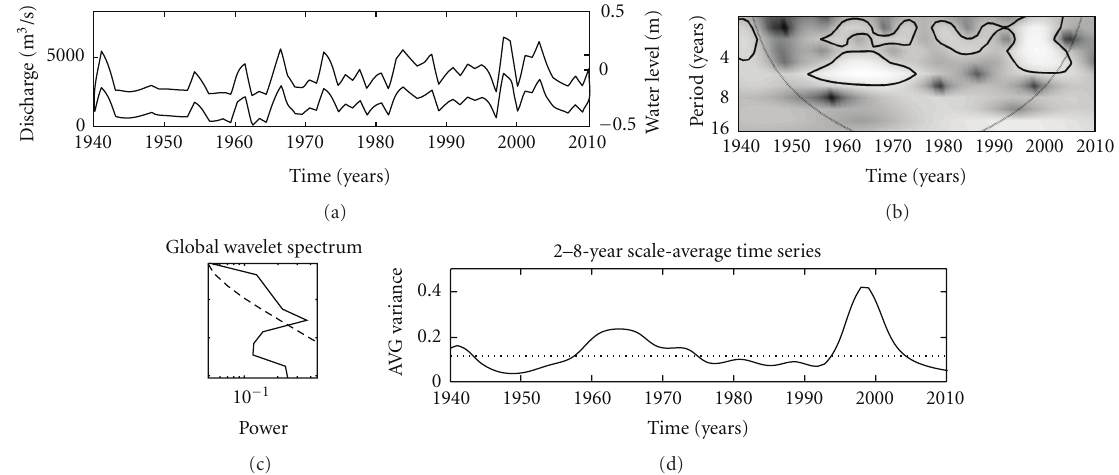
Figure 7: Freshwater discharge and water level in Ipanema (a), cross-wavelet between freshwater and water level in Ipanema (b), global wavelet spectrum (c), and average variance between 2 and 8 years